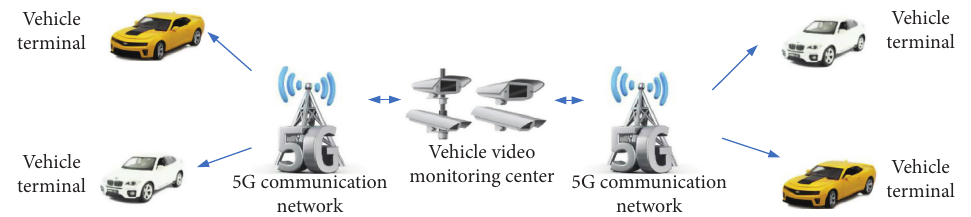
Figure 2: Vehicle highway monitoring system based on GPS